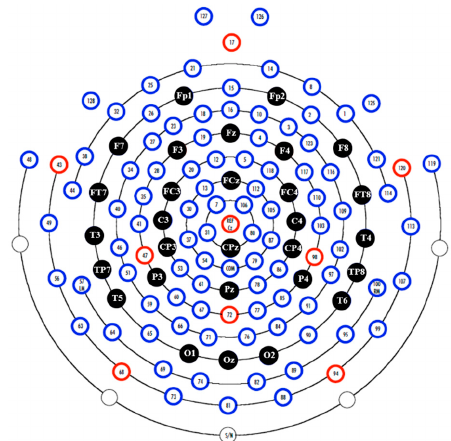
Figure 4. 128 channel map of the HydroCel GSN. The 29 channels marked in black were used analysis. for